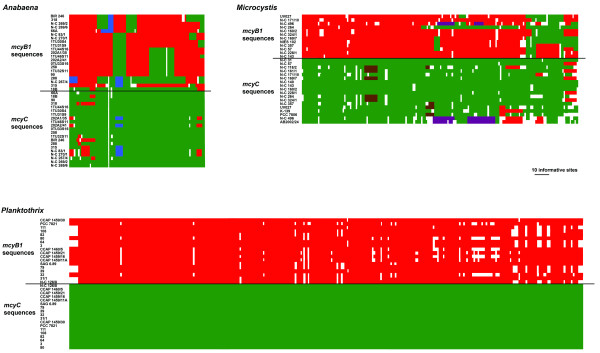
Informative sites in Anabaena, Microcystis and Planktothrix mcyB1C data sets. Informative sites are defined as positions with at least two different nucleotides in which each of the variants occurs at least twice. Identical nucleotides have the same colour and the colours thus display phylogenetic affinity.